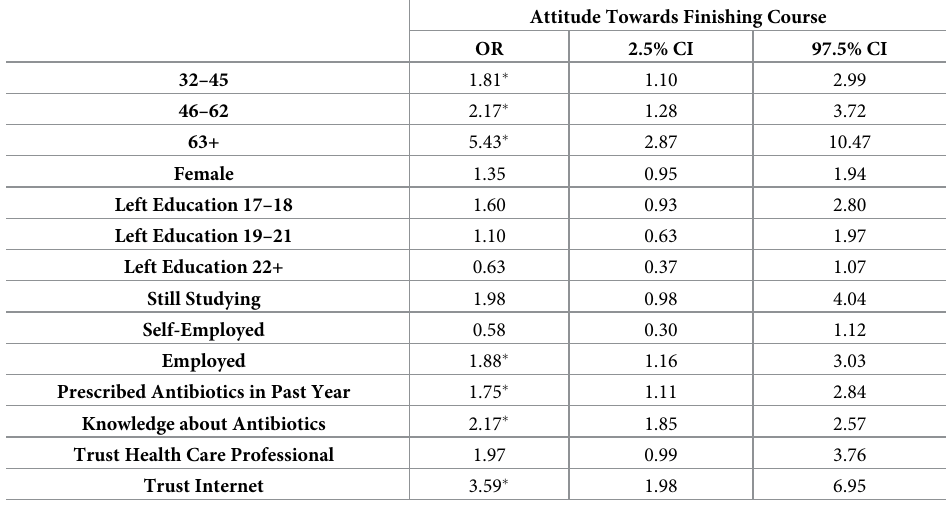
Table 6. Logistic regression analysis of eurobarometer attitude variable.